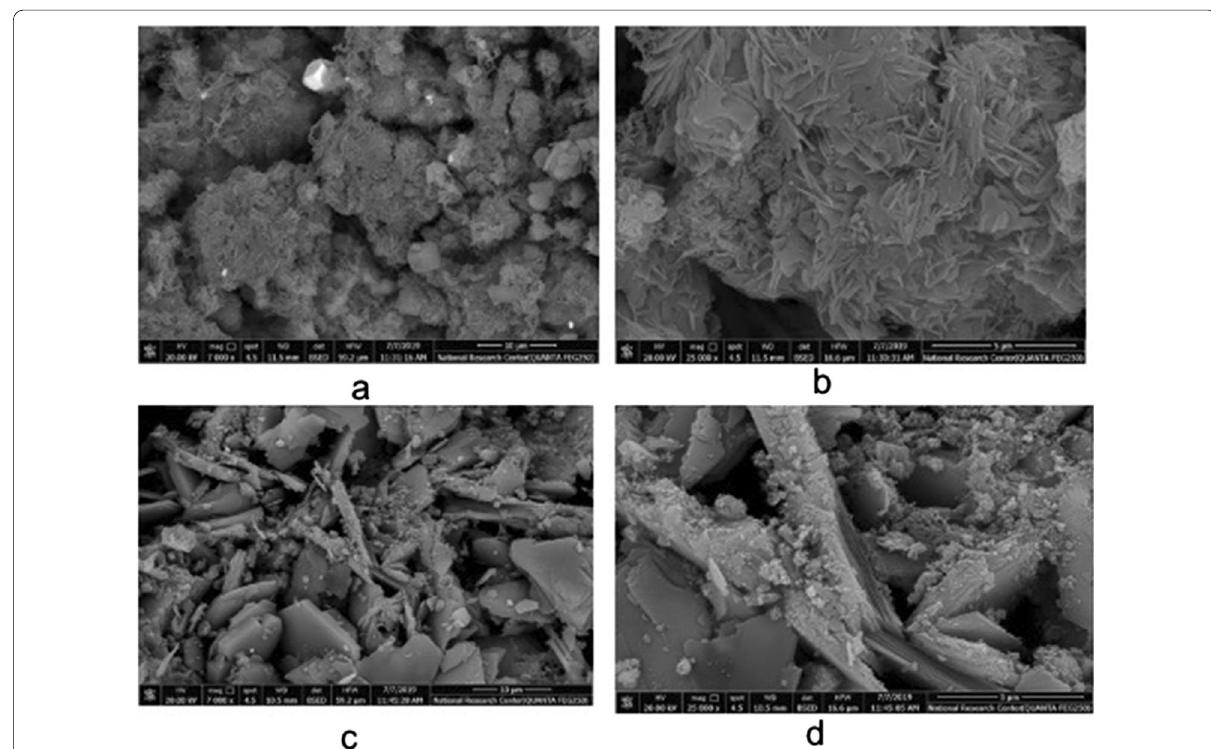
Fig. 6 14 days C3A composite sample cured in distilled water ( a , b ) and cured in artificial saliva solution ( c , d